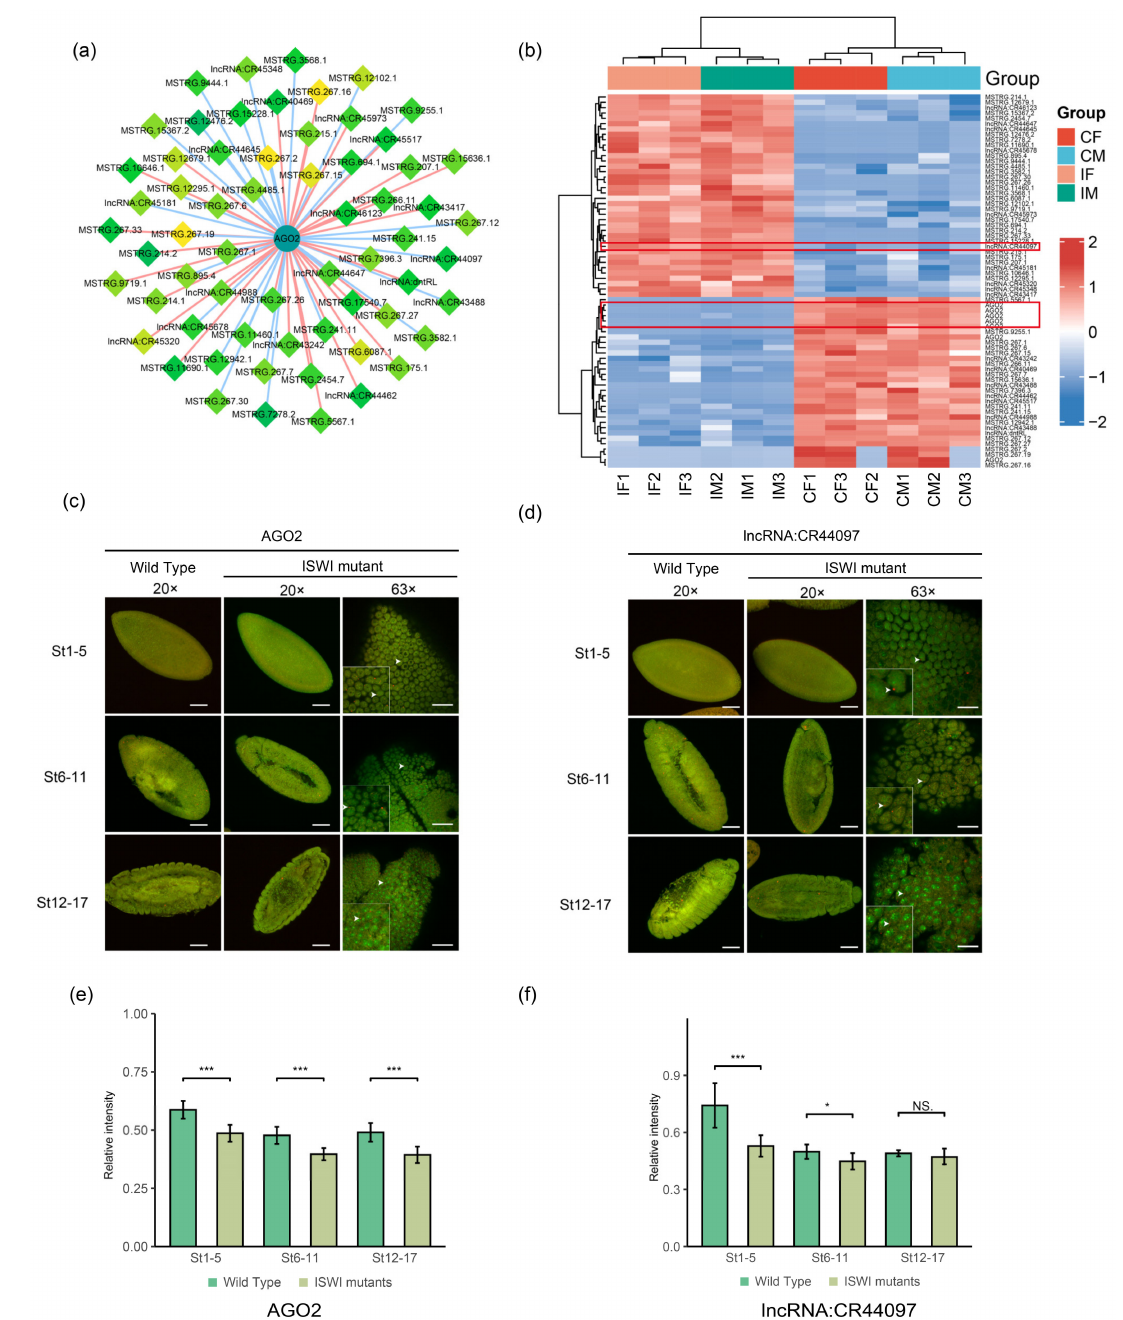
axis above, and the development stage of the sample is shown in the left vertical axis. The red pseudo- color is the signal from Probe and the green pseudo-color is the signal from nucleus. RNA subcellular Location Patterns in mutant Drosophila . 63 × : Scale bars, 30 µ m. The white arrow head represents the subcellular localization of the probe signal. ( e , f ) Relative fluorescence intensity of me31B ( e ) and hsromge ( f ) signals in wild-type and mutant Drosophila embryos. The relative fluorescence intensity was calculated by the ratio of RNA signal to DAPI signal. The asterisk indicates p < 0.05 for the two-tailed Student’s t -test. NS. represents p value > 0.05 without significant difference, *** means abnormally significant difference, p -value was <0.001.